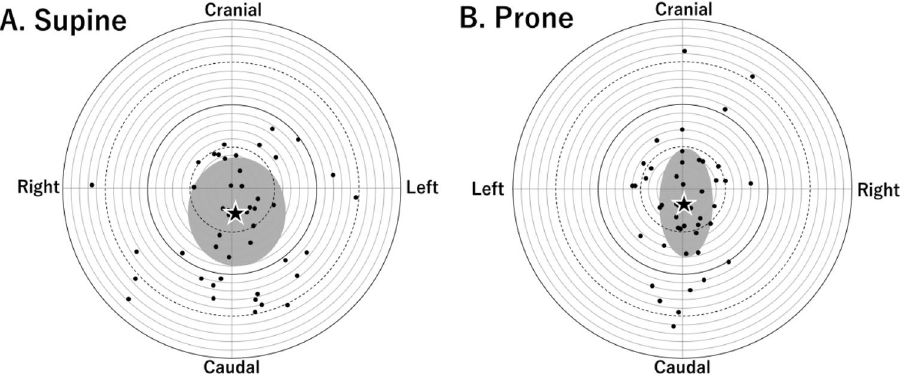
Figure 3. Landing points of the drone. ( A ) and ( B ) indicate the landing points of the drone in supine and prone positions, respectively. The center of the circles represents the umbilicus. The distance between a circle and the next circles is 1 cm. The black dots denote the individual landing points. The black stars denote the average landing position with the gray areas indicating the standard